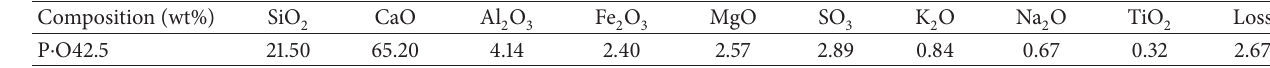
Table 1: Chemical composition of cement (wt%).